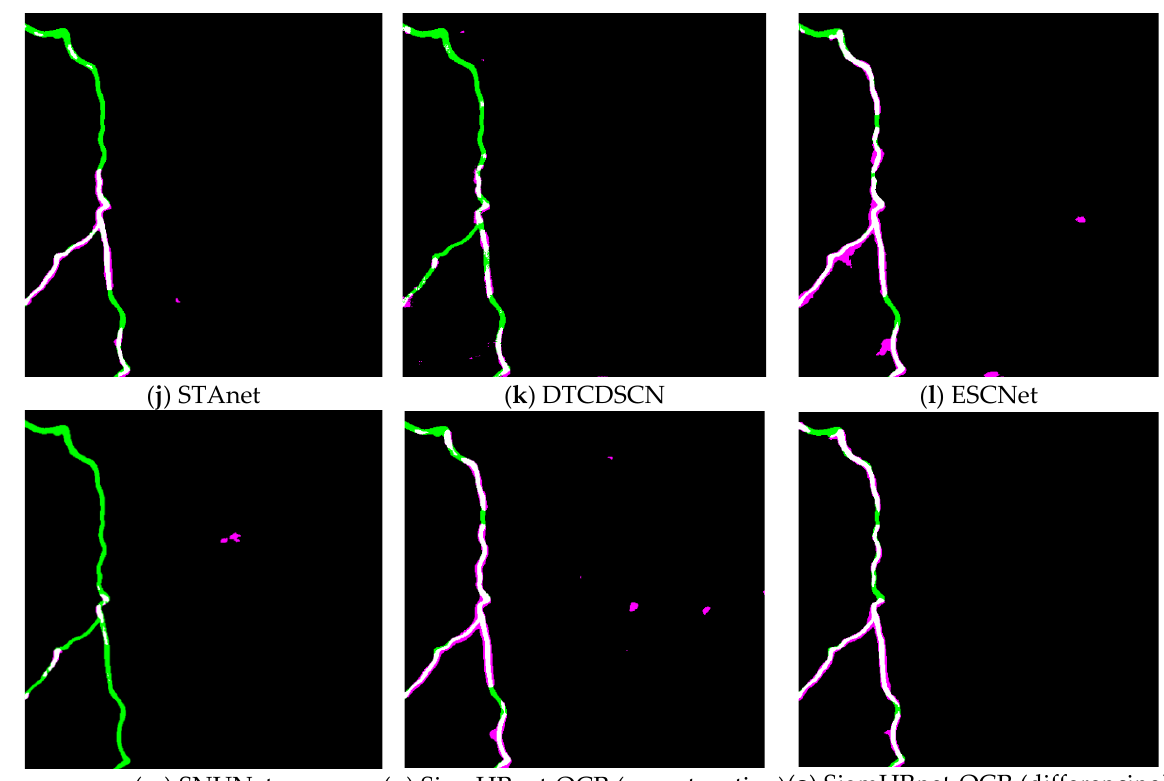
Figure 11. Visual comparison of the change detection results of different methods (the green and magenta color represents missing pixels and false-detected pixels in the change detection result, respectively).